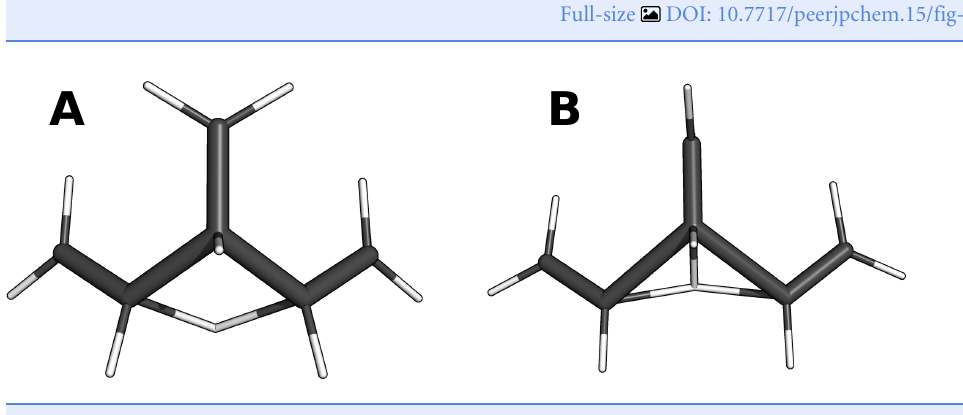
Figure 5 Comparison of the TS located (A) searching for the TS of reaction 84 (B). A taken from the first run, coordinates for B from SI of the work of Zimmerman (2013a)